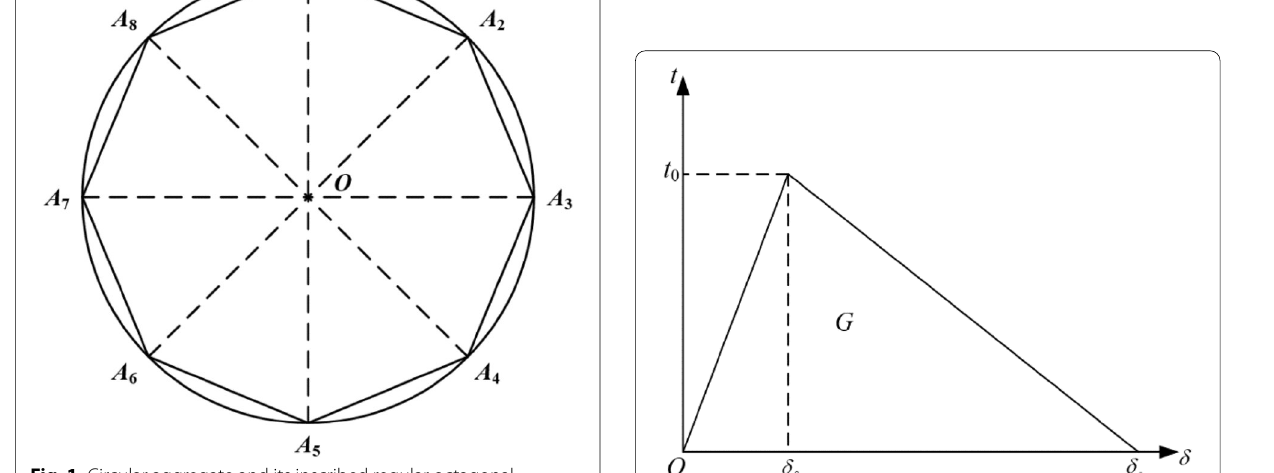
Fig. 1 Circular aggregate and its inscribed regular octagonal aggregate Fig. 2 Bilinear cohesive constitutive